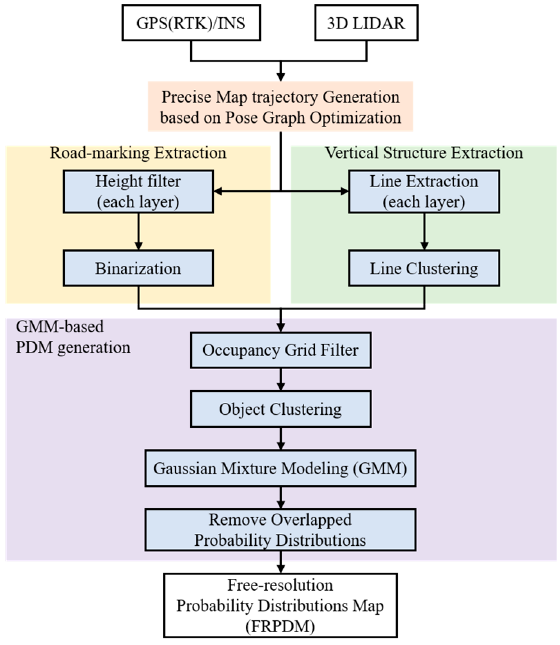
Figure 3. Flowchart of the FRPDM generation process.